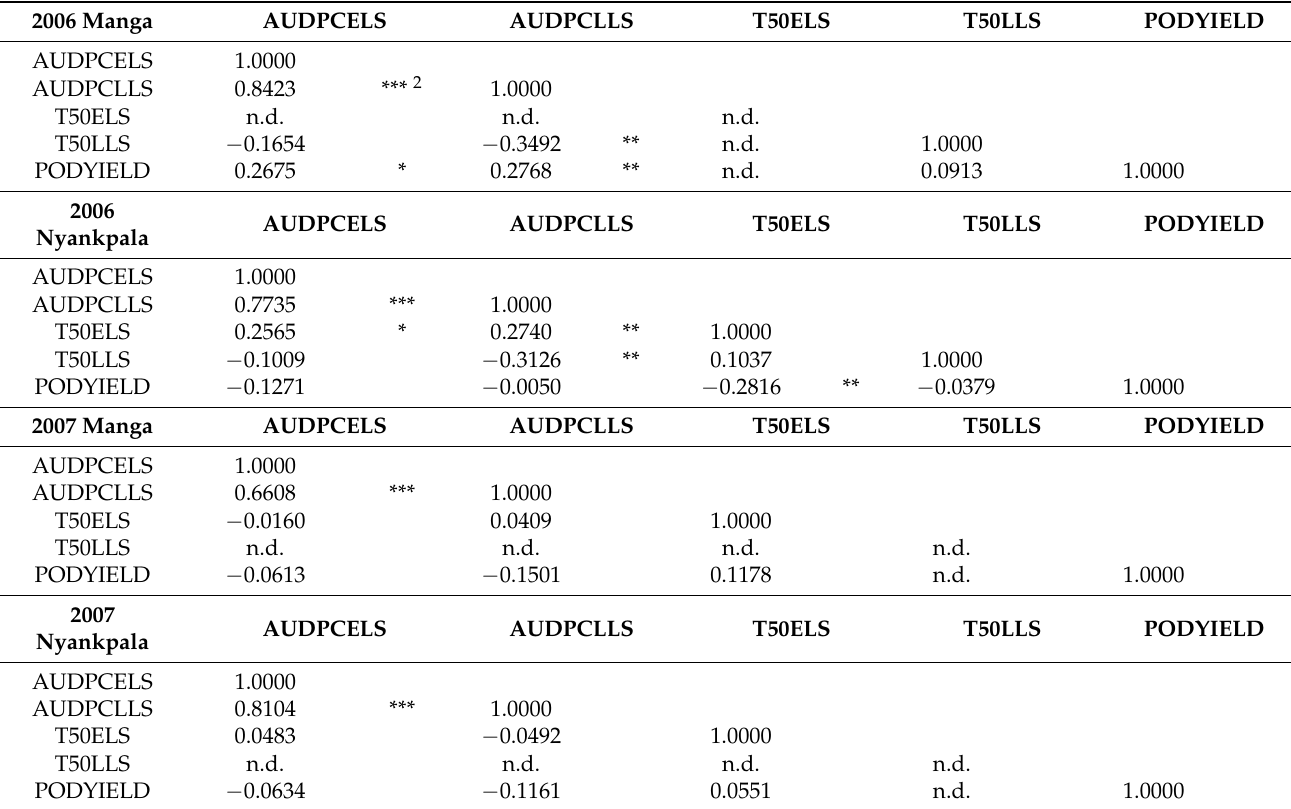
Table 6. Pearson correlations among traits, by